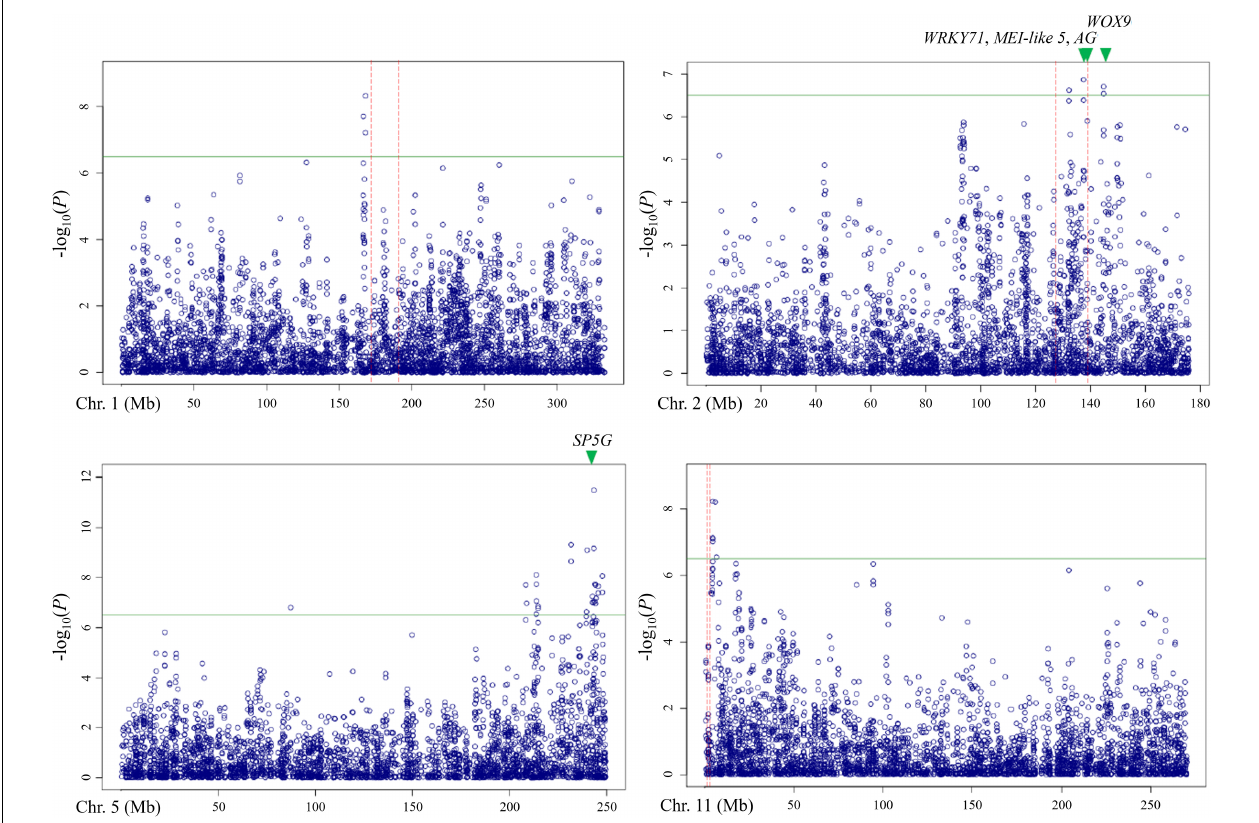
FIGURE 6 | Comparison of QTL regions from the TH RIL population and Manhattan plots from GWAS using the multiple-flowers-per-node trait. The threshold of the –log( P ) was 6.2. QTL region detected by QTL mapping are marked by red dashed lines, with green triangles indicating the position of the candidate genes. TABLE 5 | Candidate genes for the multiple-flowers-per-node trait in the reference genome. Gene annotation Gene ID (CA.PGAv.1.6.) Chr. Physical location in CM334 v1.6